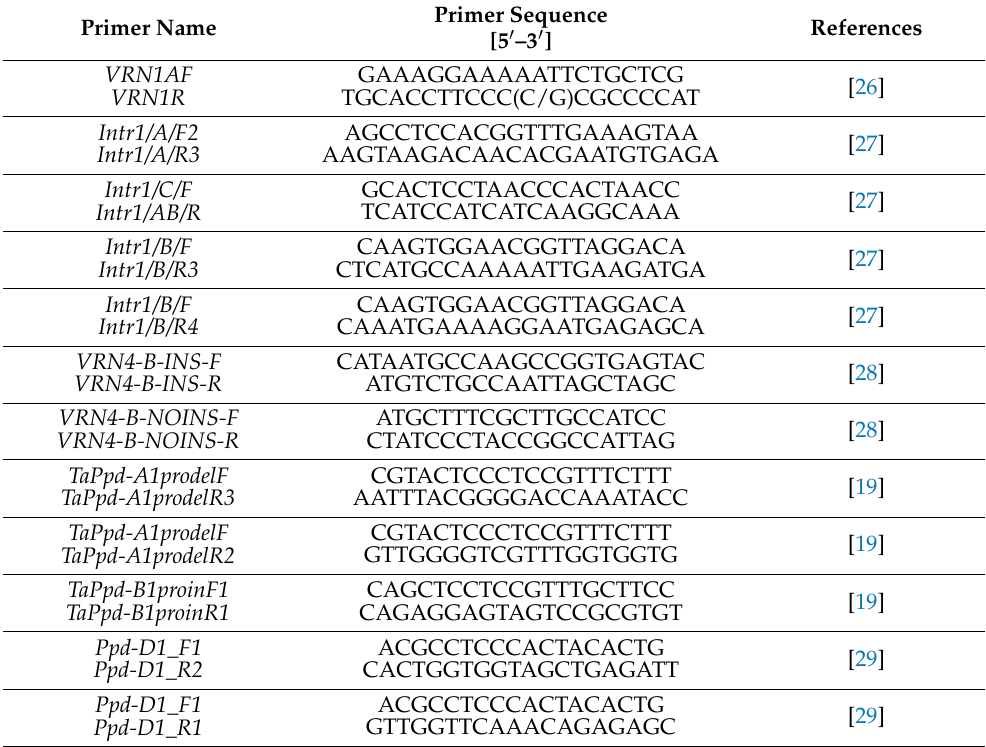
Table 8. PCR assays used to genotype Solina accessions for alleles at major vernalization and photoperiod loci.